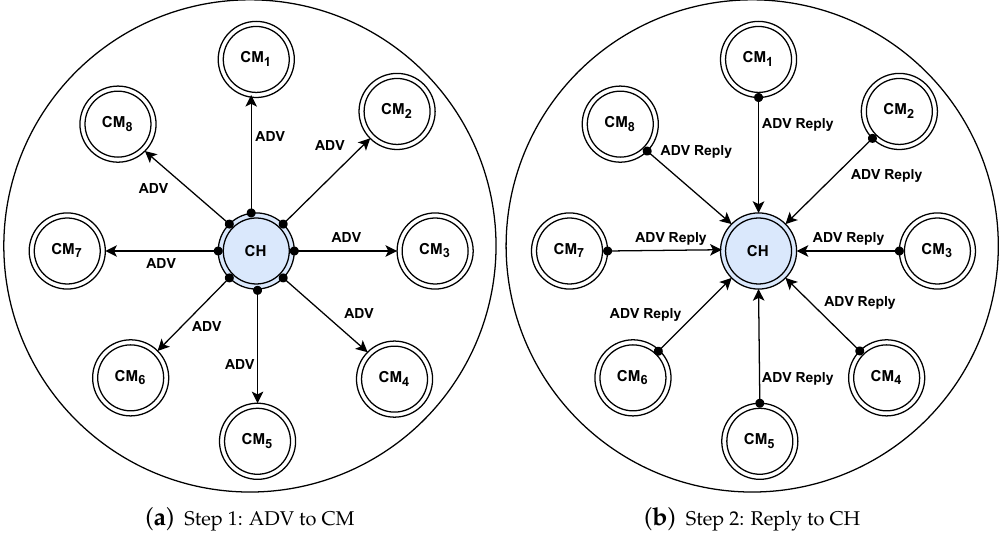
Figure 6. Selection of the energy-efficient node as CH. ( a ) Step 1: ADV to CM; ( b ) Step 2: Reply to